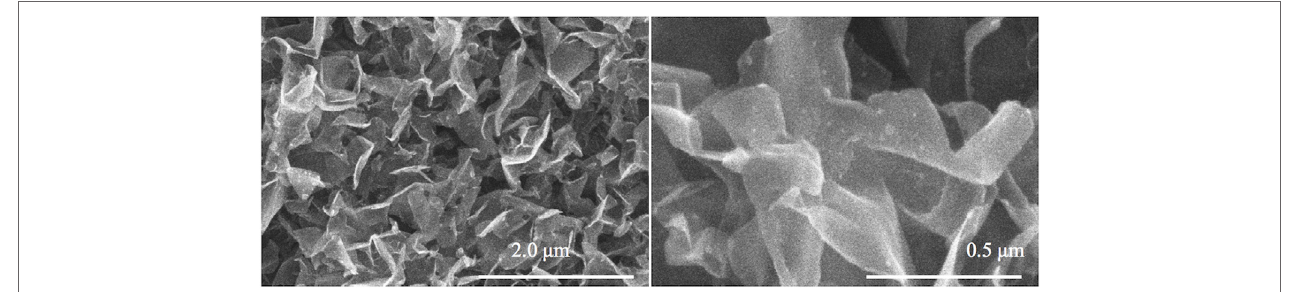
FigUre 1 | Scanning electron micrograph images of C x (BN) petals fabricated on electrode